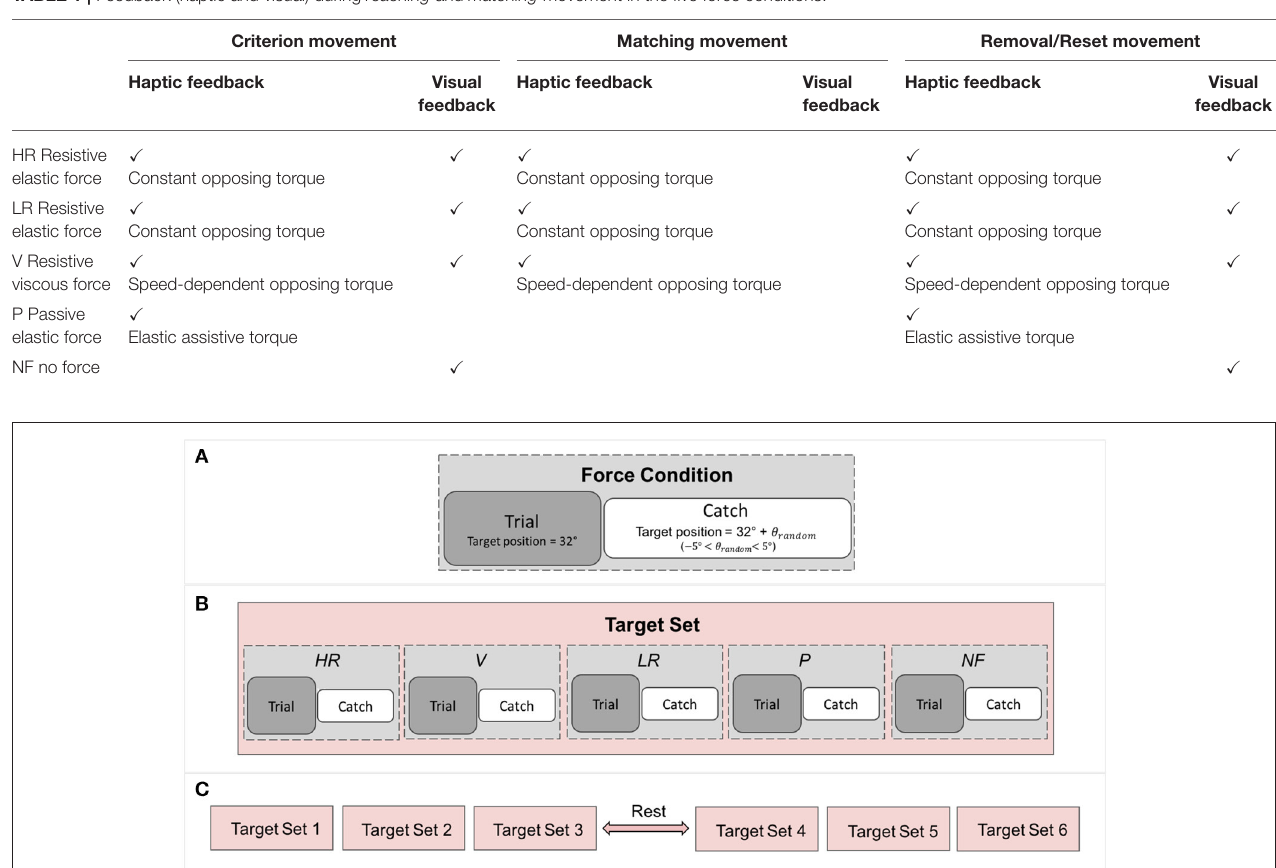
FIGURE 3 | Breakdown of the experiment: (A) Each force condition comprises a trial followed by a catch trial in which the target position is randomized to control for subject adaptation. (B) A target set contains all the force condition. (C) The experiment comprises 6 target sets, resulting in 6 repetitions of each force